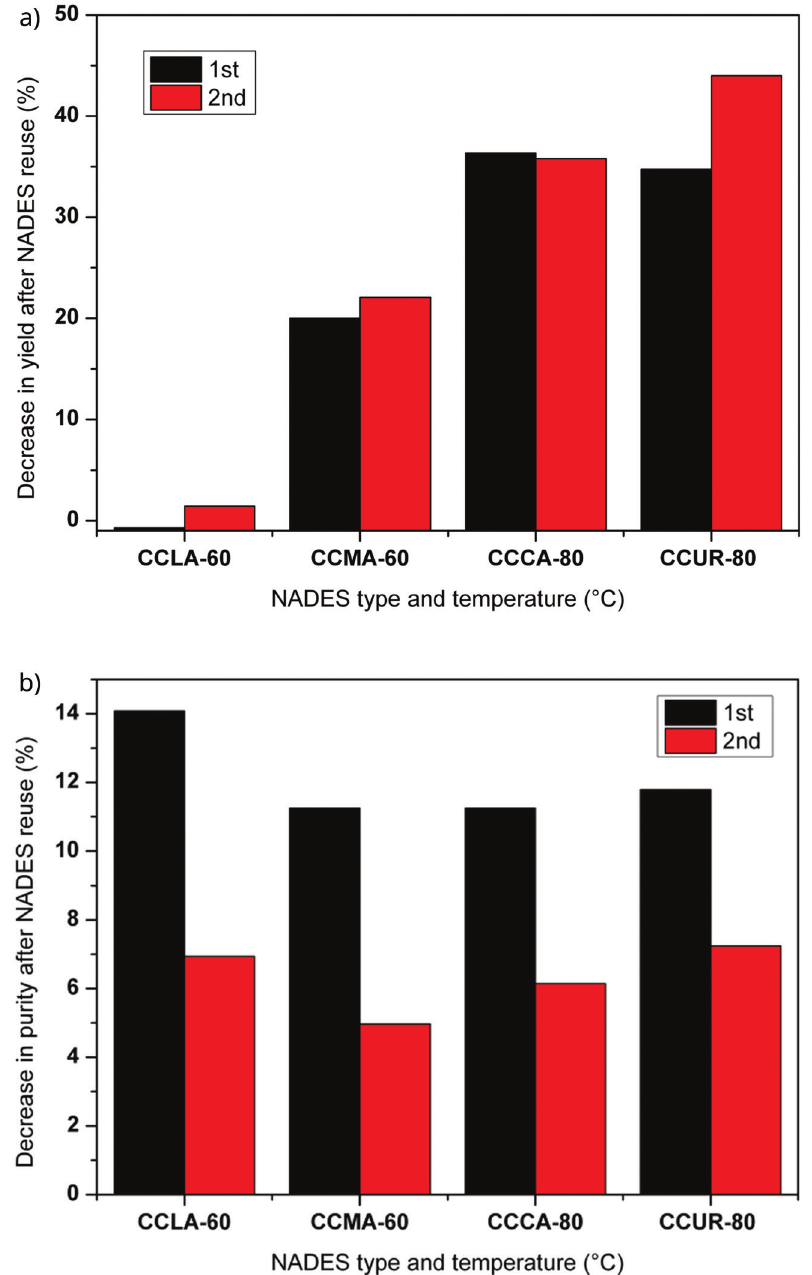
Figure 5: Influence of the NADES recycle and reuse on chitin (a) yield and (b) purity. The same conditions were used, as described in Figure